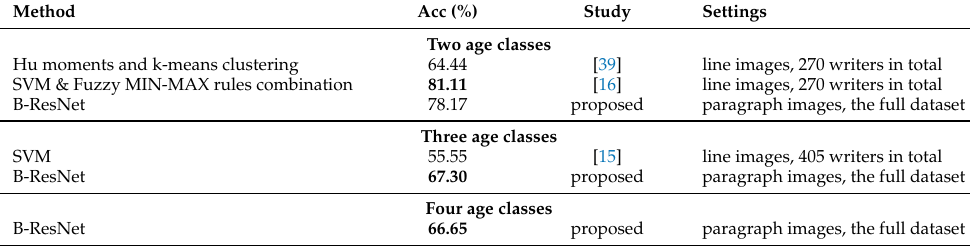
Table 7. Comparison of accuracy scores for age classification accuracy on the KHATT dataset for different numbers of age